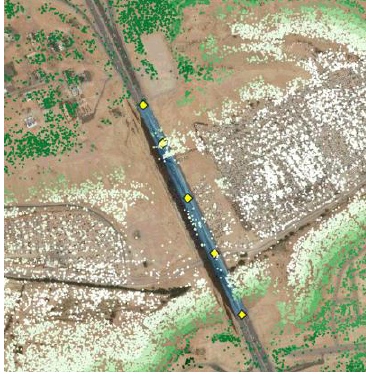
Figure 10. Mean amplitude image in SAR geometry with approximate CRs locations (Left). Bridge optical imagery showing the cars holding facility underneath it (right) GNSS longitude latitude coordinates on geocoded amplitude